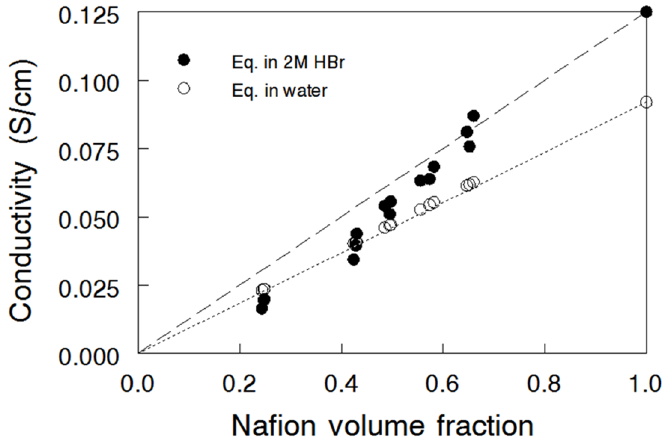
Figure 4. In ‐ plane ionic conductivity of Nafion nanofiber composite membranes as a function of Nafion volume fraction at 25 °C ( ○ ) N(fibers)/PPSU measured in water; ( ● ) N (fibers)/PPSU measured in 2 M HBr. The conductivity of Nafion ® 115 in water and in 2 M HBr is 0.084 S/cm and 0.107 S/cm, respectively.